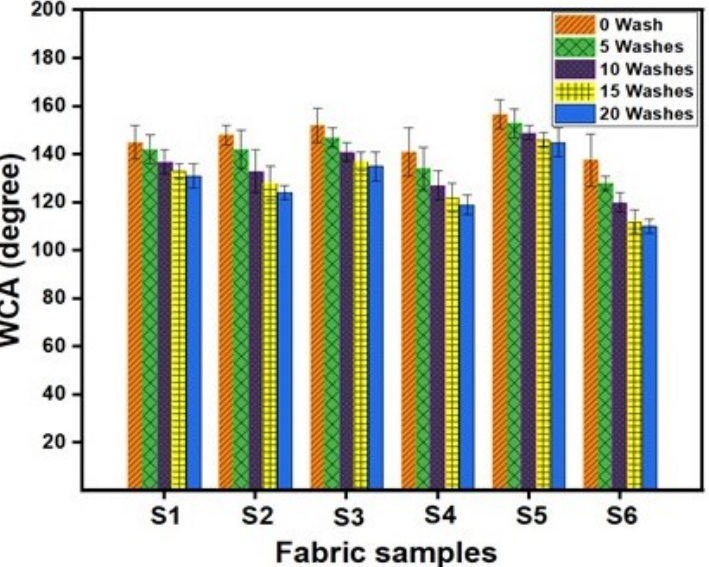
Figure 10. The water contact angle of modified fabrics before and after various washing cycles.